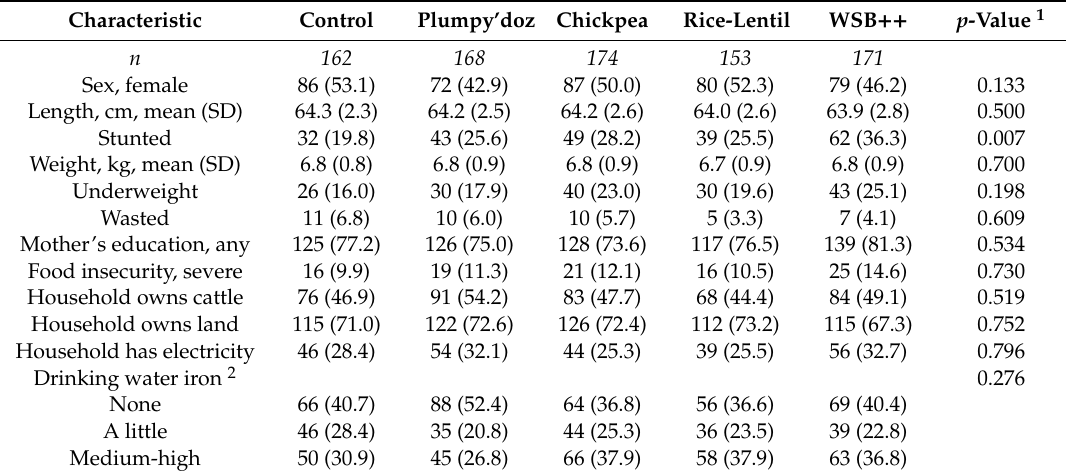
Table 2. Child and household characteristics of micronutrient assessment participants at enrollment by assigned supplementation group in a randomized complementary food supplementation trial in Bangladesh.